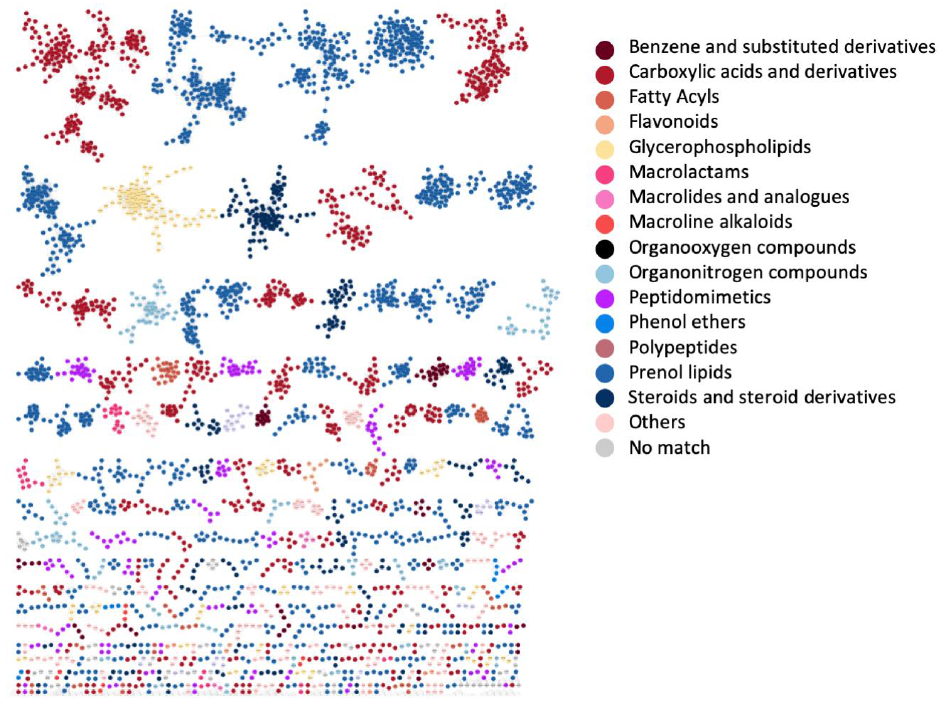
Figure 5. Marine sediment Salinispora / Streptomyces molecular network colored by 15 selected chemical class terms as indicated in the legend. In total, 50 different class terms were annotated in the network using MolNetEnhancer, indicating that the metabolic output of the Salinispora / Streptomyces strains is chemically very diverse. We can observe that the larger molecular families are mostly annotated with prenol lipids (blue) and carboxylic acids and derivatives (red). Furthermore, for a couple of MFs no chemical class annotations were obtained as no candidate structures were retrieved through any of the annotation tools.